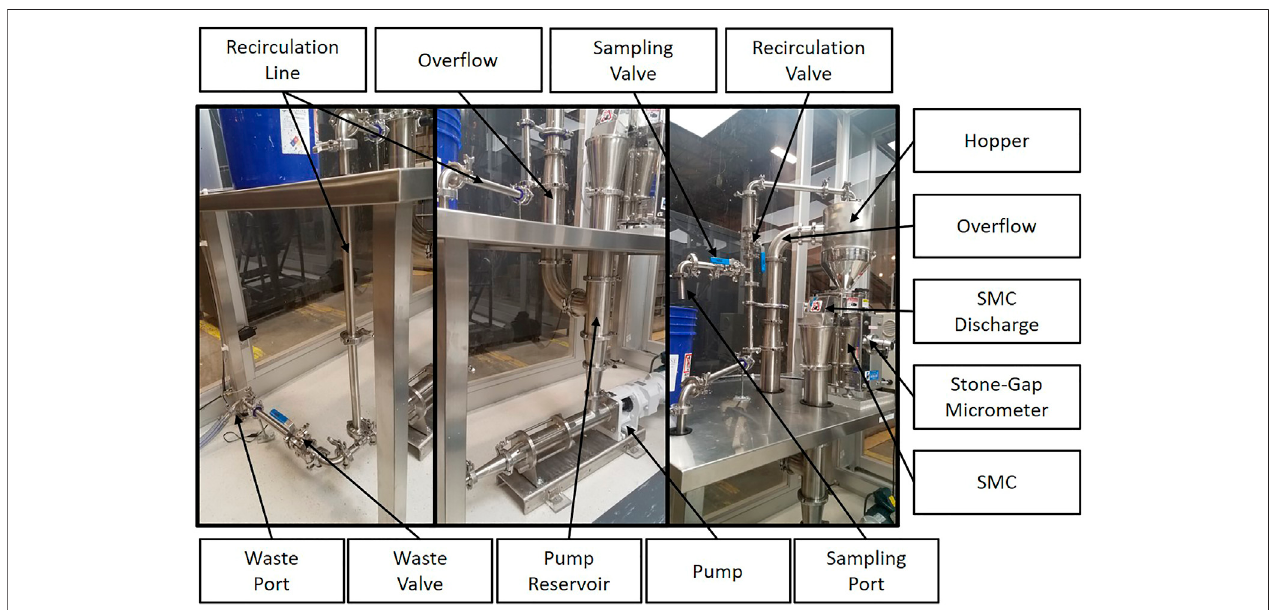
FIGURE 2 | Supermasscolloider re fi ning system